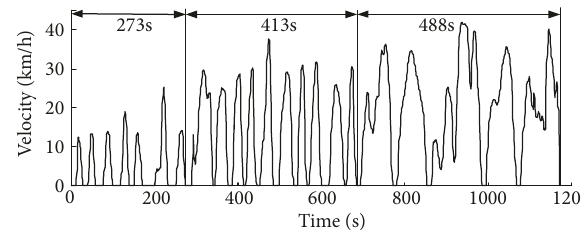
Figure 6: Comprehensive bus driving